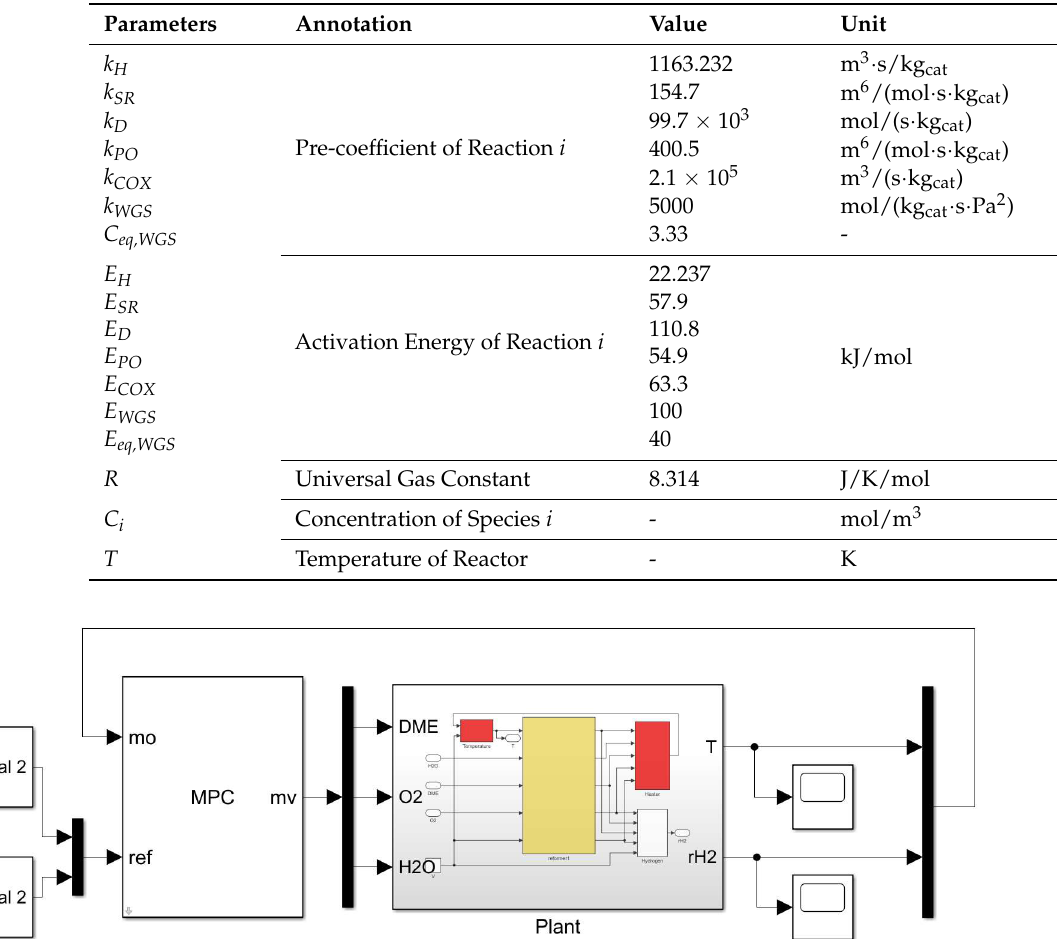
Table 3. Reaction kinetic parameters.